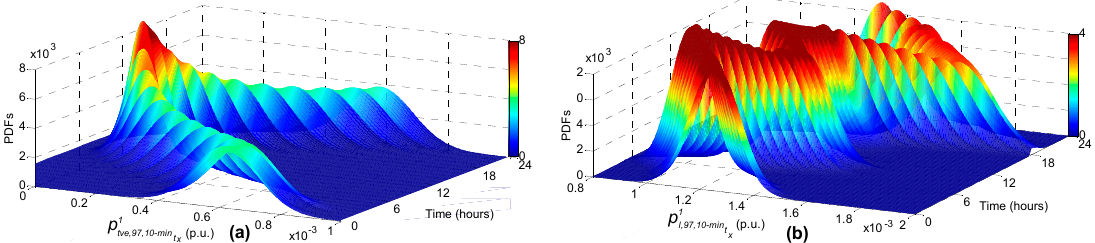
Figure 4. Surface plots based on the PDFs for a working day in January at node 97. ( a ) EV charging power; ( b ) node load power.